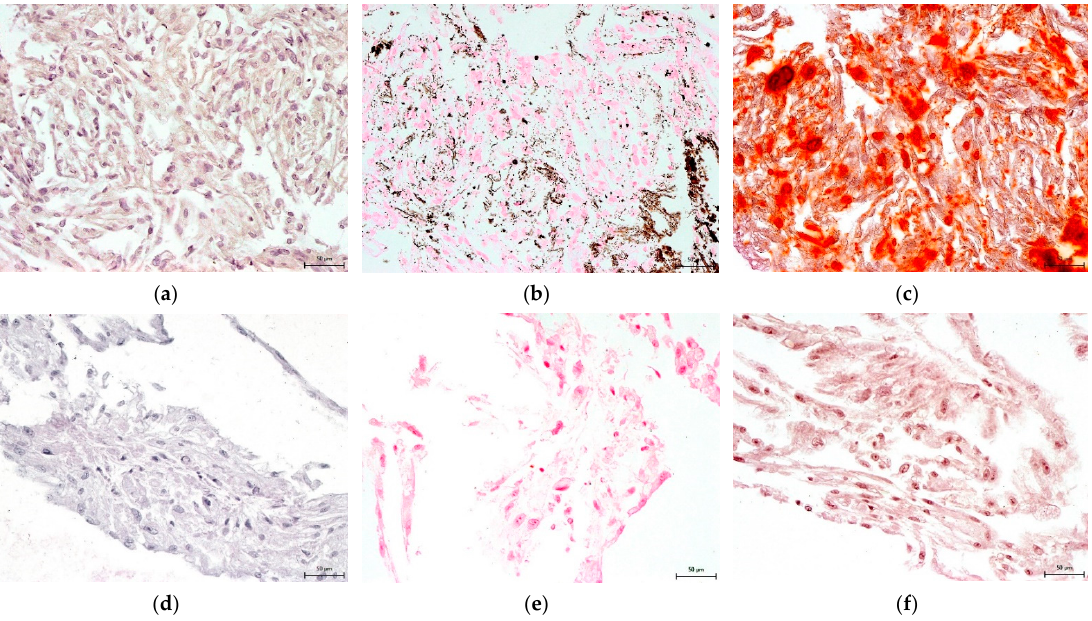
Figure 12. Detection of osteogenic differentiation in the extracellular matrix of hNDP-SCs cultivated in the FBS-culture medium. Scale bar 50 μ m: ( a – c ) After 3-week cultivation in osteogenic differentiation medium; ( d – f ) undifferentiated hNDP-SCs; ( a , d ) immunocytochemical detection of osteocalcin (brown or rusty areas); ( b , e) histological detection of calcium phosphate deposits after von Kossa stain (dark brown or black spots); ( c , f ) histological detection of calcium deposits after Alizarin Red stain (red areas).